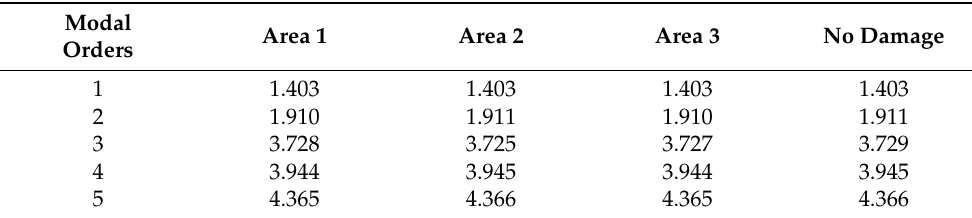
Table 12. Effect of damage in different areas of shear joints on the self-vibration frequency of the structure.